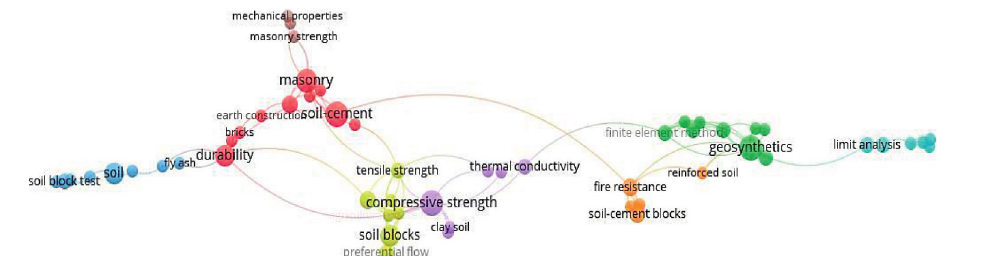
Figure 5: Keyword network